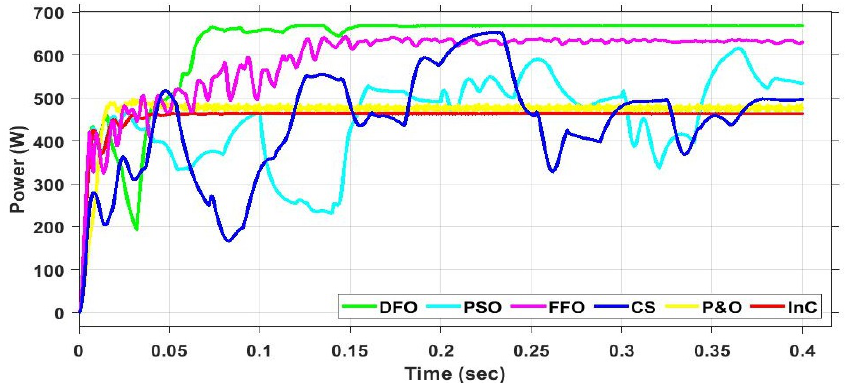
Figure 28. PS2 power comparison between all algorithms for MLPE Distributed PV